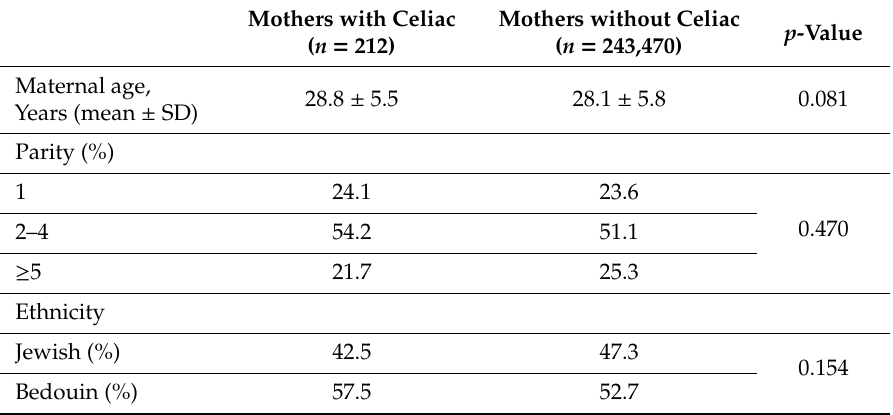
Table 1. Characteristics in study